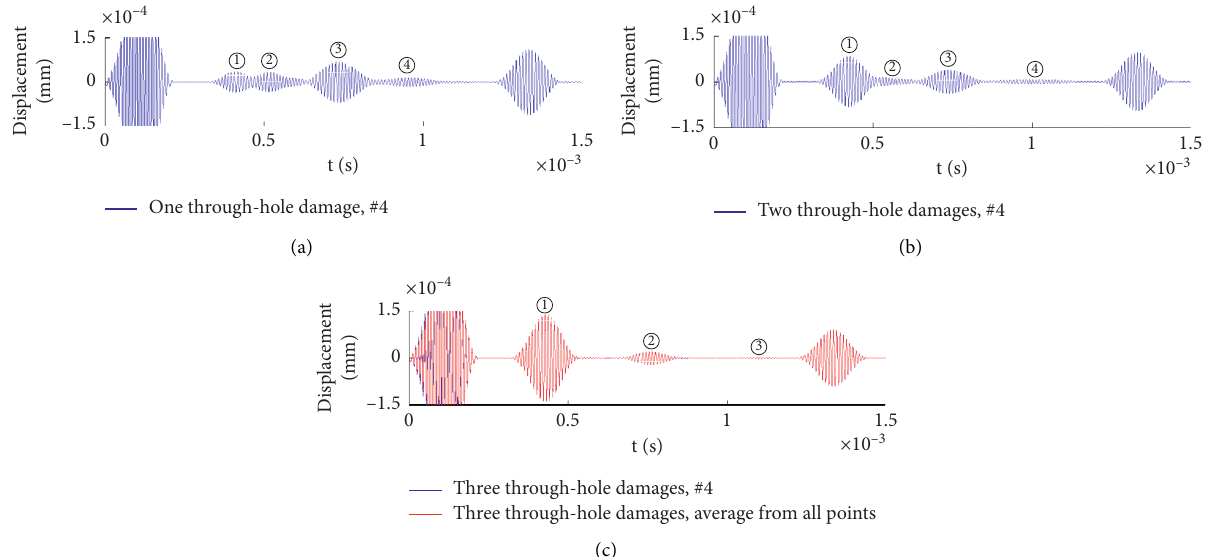
Figure 15: Time domain waveforms received from multiple through-hole damages located in different planes: (a) one damage in plane I; (b) two damages in planes I and III; and (c) three damages in planes (I) III and